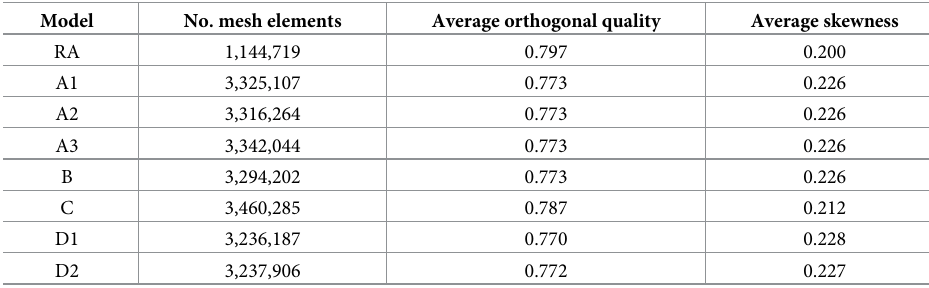
Table 2. Mesh settings and quality